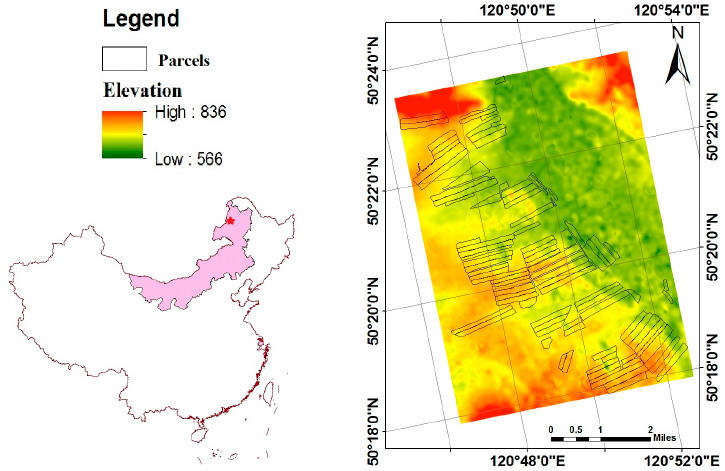
Figure 1. The test site in Inner Mongolia, China. The left subpanel shows the location of the Inner Mongolia Autonomous Region of China (in pink). The red star shows the location of the test site. The right subpanel shows the sample parcels in the test sites overlaid on the related topography (Digital Elevation Model).